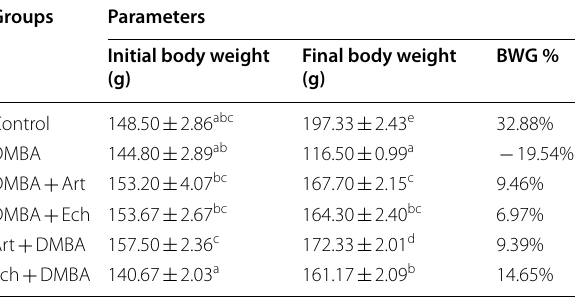
Each value represents the mean (M) Values with different superscript letters are considered significantly different ( P < 0.05) Values with same superscript letters are considered non-significantly different ( P < 0.05)